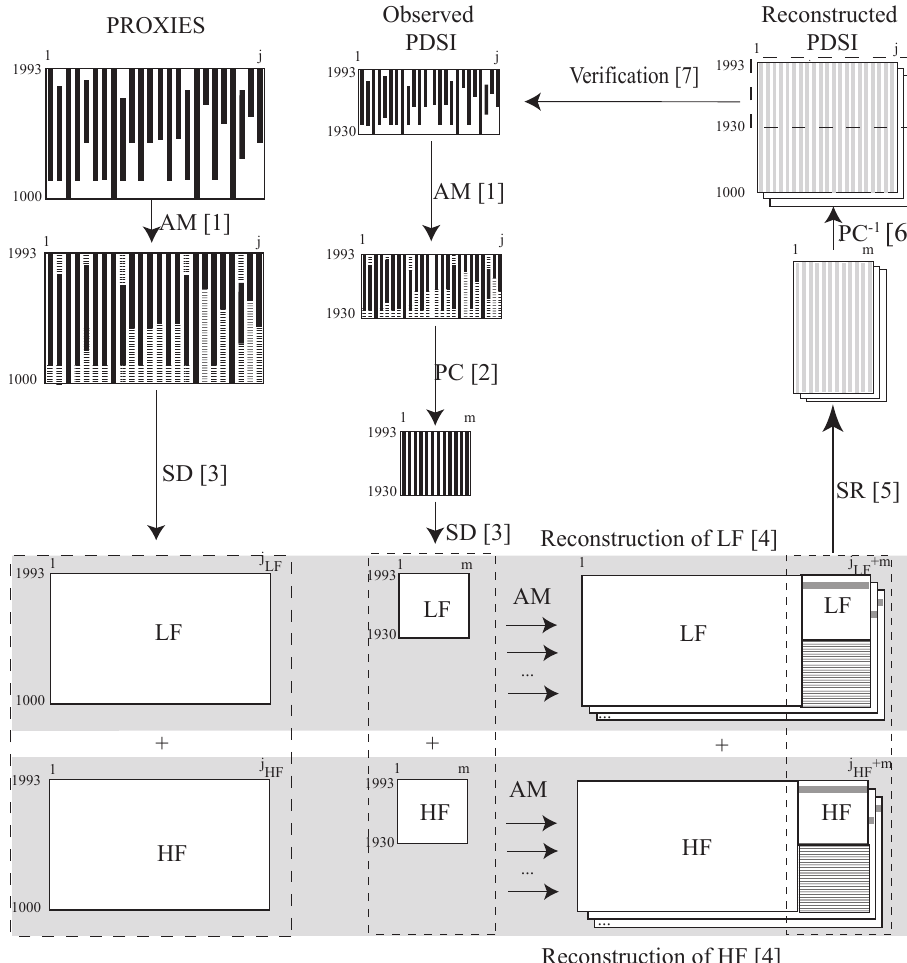
Fig. 2. Summary of the spectral analogue method. Missing values in the proxy and summer PDSI matrix are filled with the analogue method (AM[1]). The PDSI are reduced to m principal components. (PC [2]). Proxy and PDSI (PC) series are decomposed into their LF (0 < f < 0 . 08) and HF (0 . 08 < f < 0 . 5) components using a Fast Fourier Transform procedure (SD [3]). The reconstruction for each band is achieved using the AM [4]. This is done iteratively 100 times, and at each iteration, a random year t is removed for the calculation of validation statistics. Around year t , the [ t − 4, t + 4] surrounding years are excluded as potential analogues. This h -block procedure is particularly useful in situations, like LF series, where there exists a large autocorrelation between years, causing the best analogues to be systematically located before of after year t . At each iteration, the reconstructed HF and LF bands are summed up to recompose (SR [5]) the full spectra of each PC. The PC are back-transformed into the original PDSI series using and inverse PC procedure (PC-1, [6]). The reconstructed series are finally verified against observations (Verification [7]).